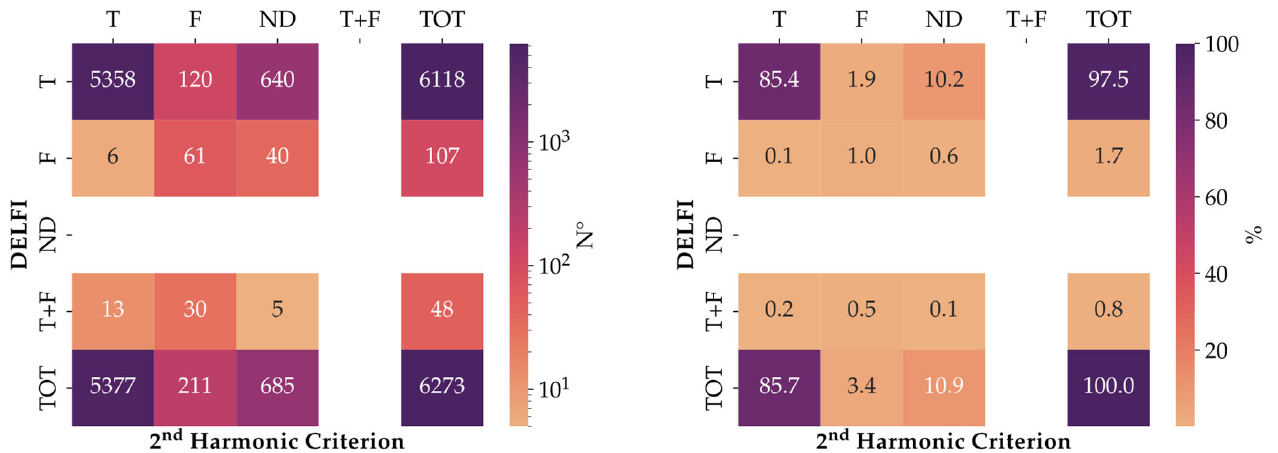
Figure 10. Validity assessment: 2nd Harmonic and DELFI outcomes for the CN Subset.